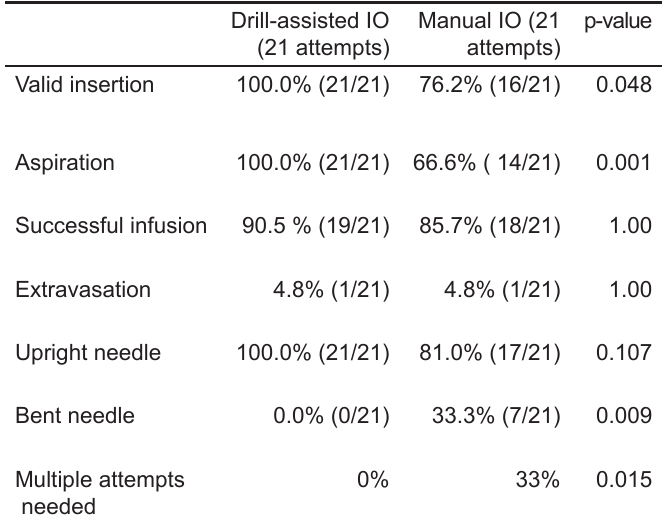
Table. Intraosseous (IO) placement